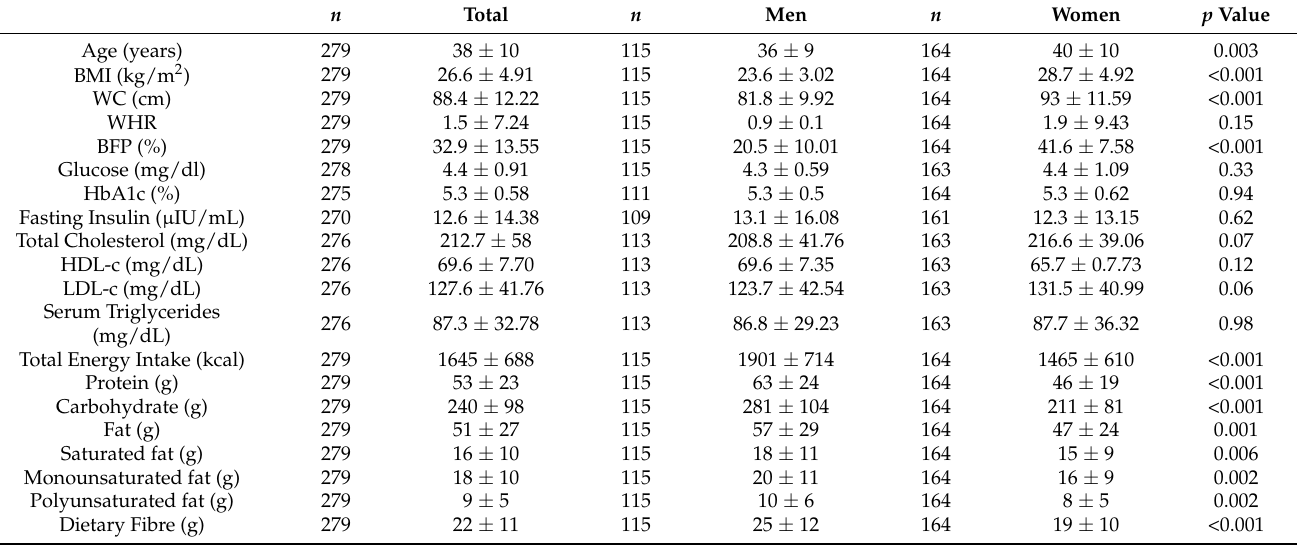
Table 1. Baseline characteristics of study